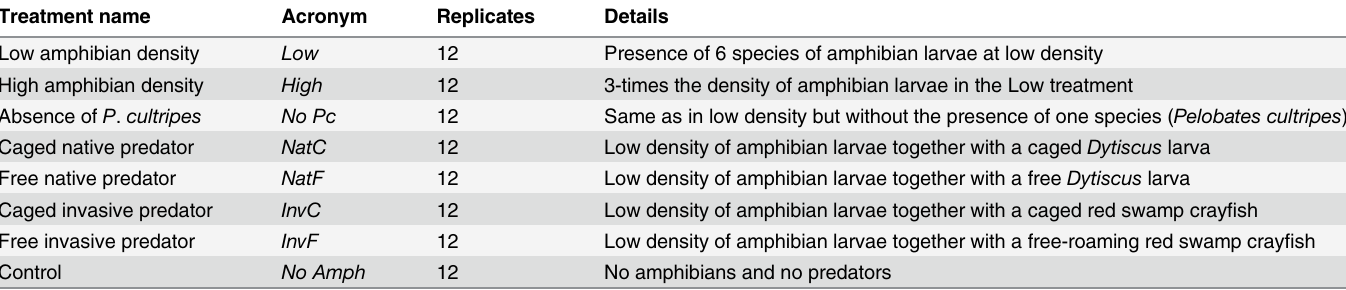
Table 1. Overview of the experimental treatments specifying name, acronym, number of replicates and details of each